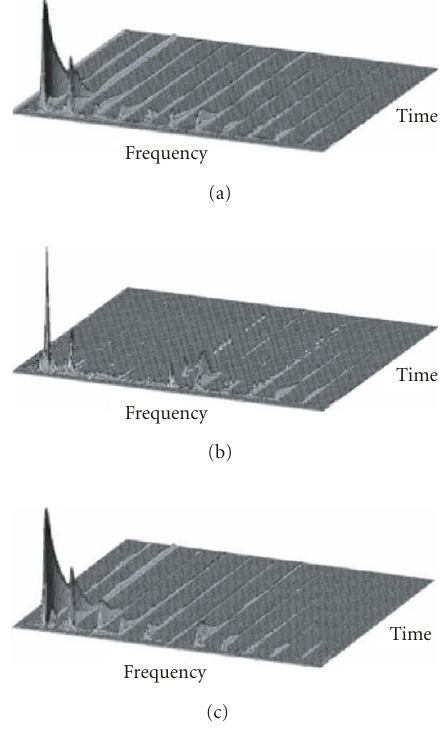
Figure 1: (a) The spectrogram of a piano playing a C (262Hz). (b) The DUET source estimate of the same piano tone when extracted from a mixture with a saxophone playing G and French horn play- ing C. (c) The source estimate of the same piano tone extracted from the same mixture using the proposed source separation